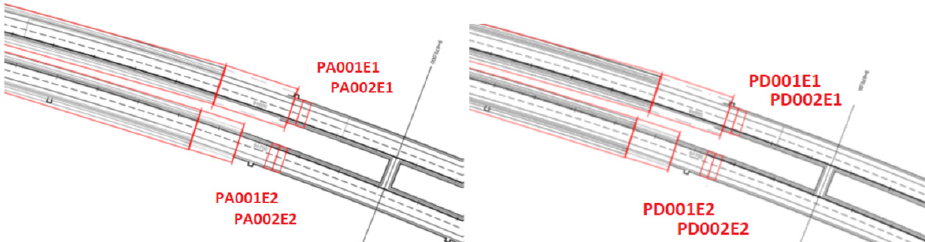
Figure 12. Detail of nomenclature assignment of different parts of the model. Definition of the nomenclature of the forward pass “PE” and the destroy pass “PD”.